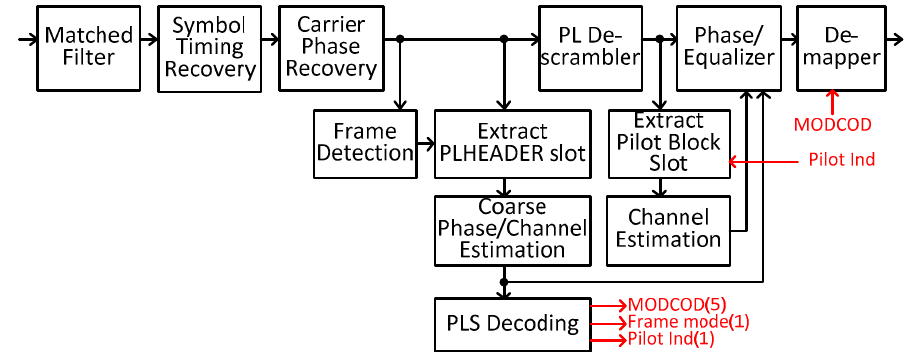
Figure 6. Block diagram of the of DVB-S2 demodulator.